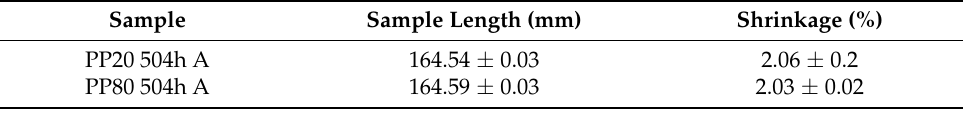
Table 1. Shrinkage values of annealed samples.